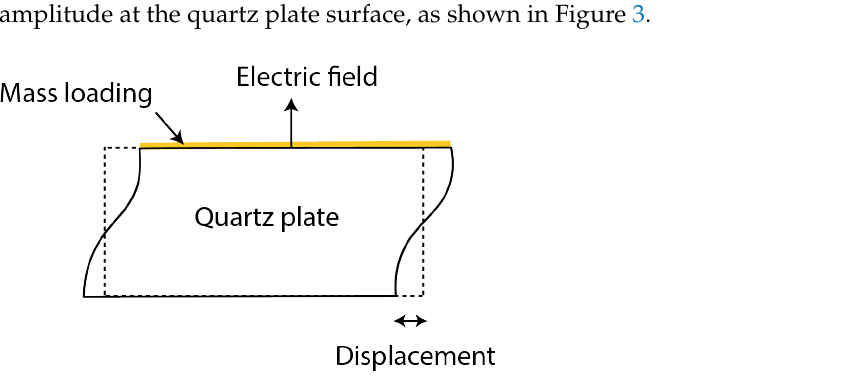
Figure 3. Thickness shear mode of Quartz Crystal